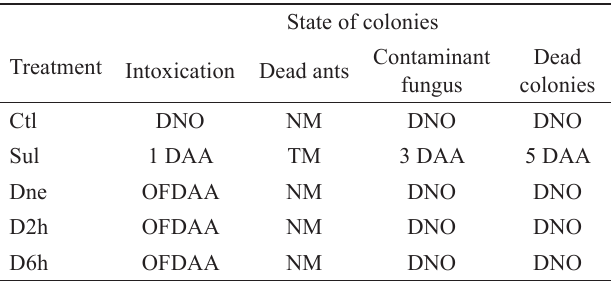
Table 3 . General state of Atta sexdens rubropilosa colonies after application of